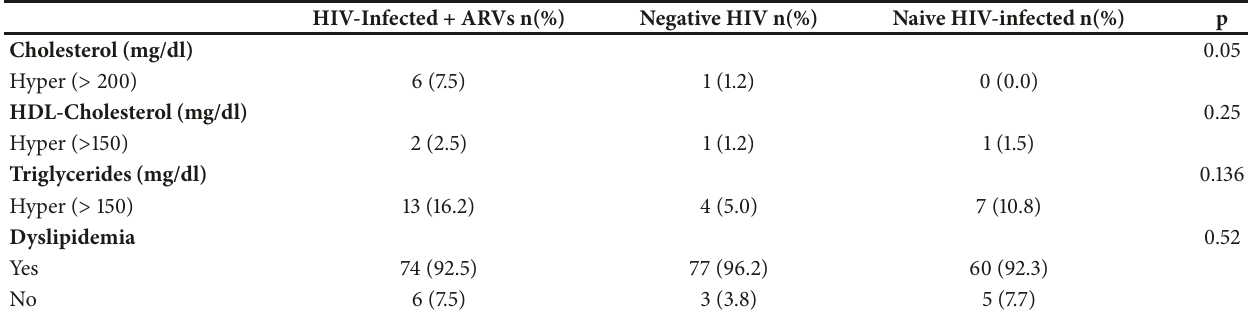
Table 3: Laboratory features in the study population according to serologic status and